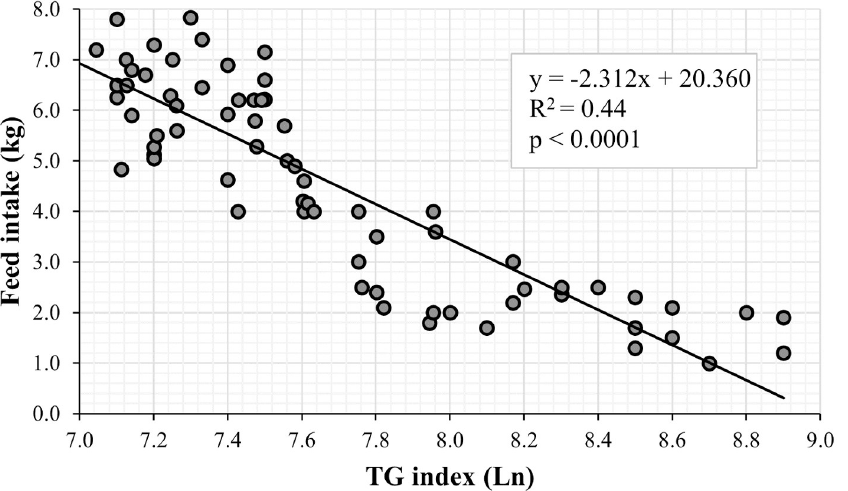
Fig 4. Regression line for feed intake in relation to the triglyceride and glucose (TG)